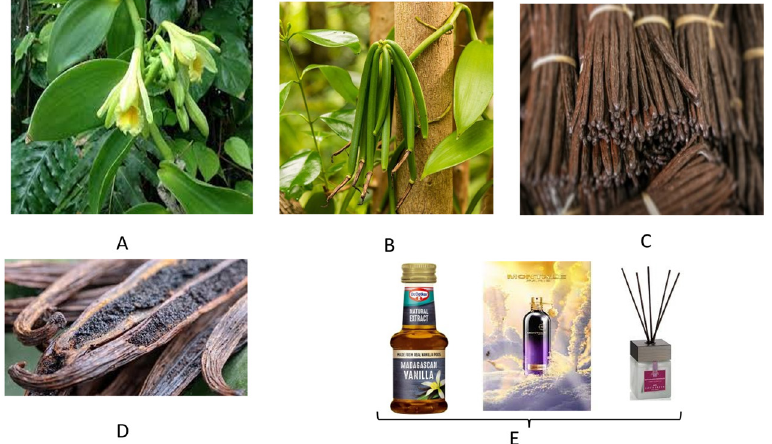
Figure 6. Details about the vanilla plant ( Vanilla planifolia ) and its products. ( A , B ) Details of the plant’s flower and pods. ( C ) Bundles of dried vanilla pods often offered for sale in the streets of many Madagascan sites. ( D ) Split vanilla pods showing their aromatic and valuable paste. ( E ) Commercially available vanilla products for cuisine (left), personal (center) and ambient deodorizing (right).